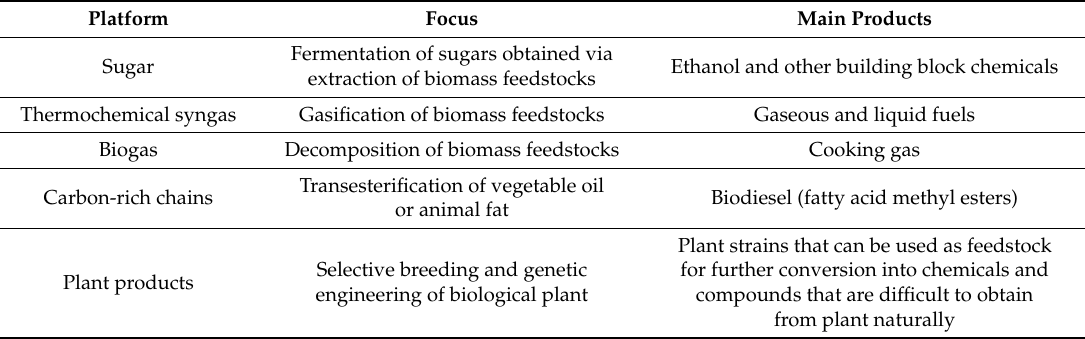
Table 2. Comparison of di ff erent biomass conversion